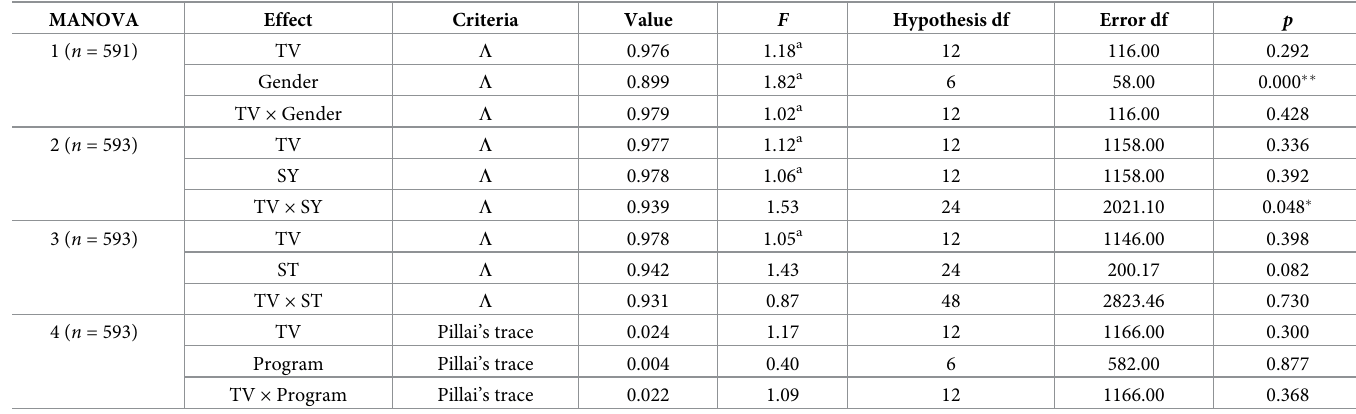
Table 4. Results from four multivariate analyses of variance examining the effect of training volume, gender, school year, sport types, and school program.